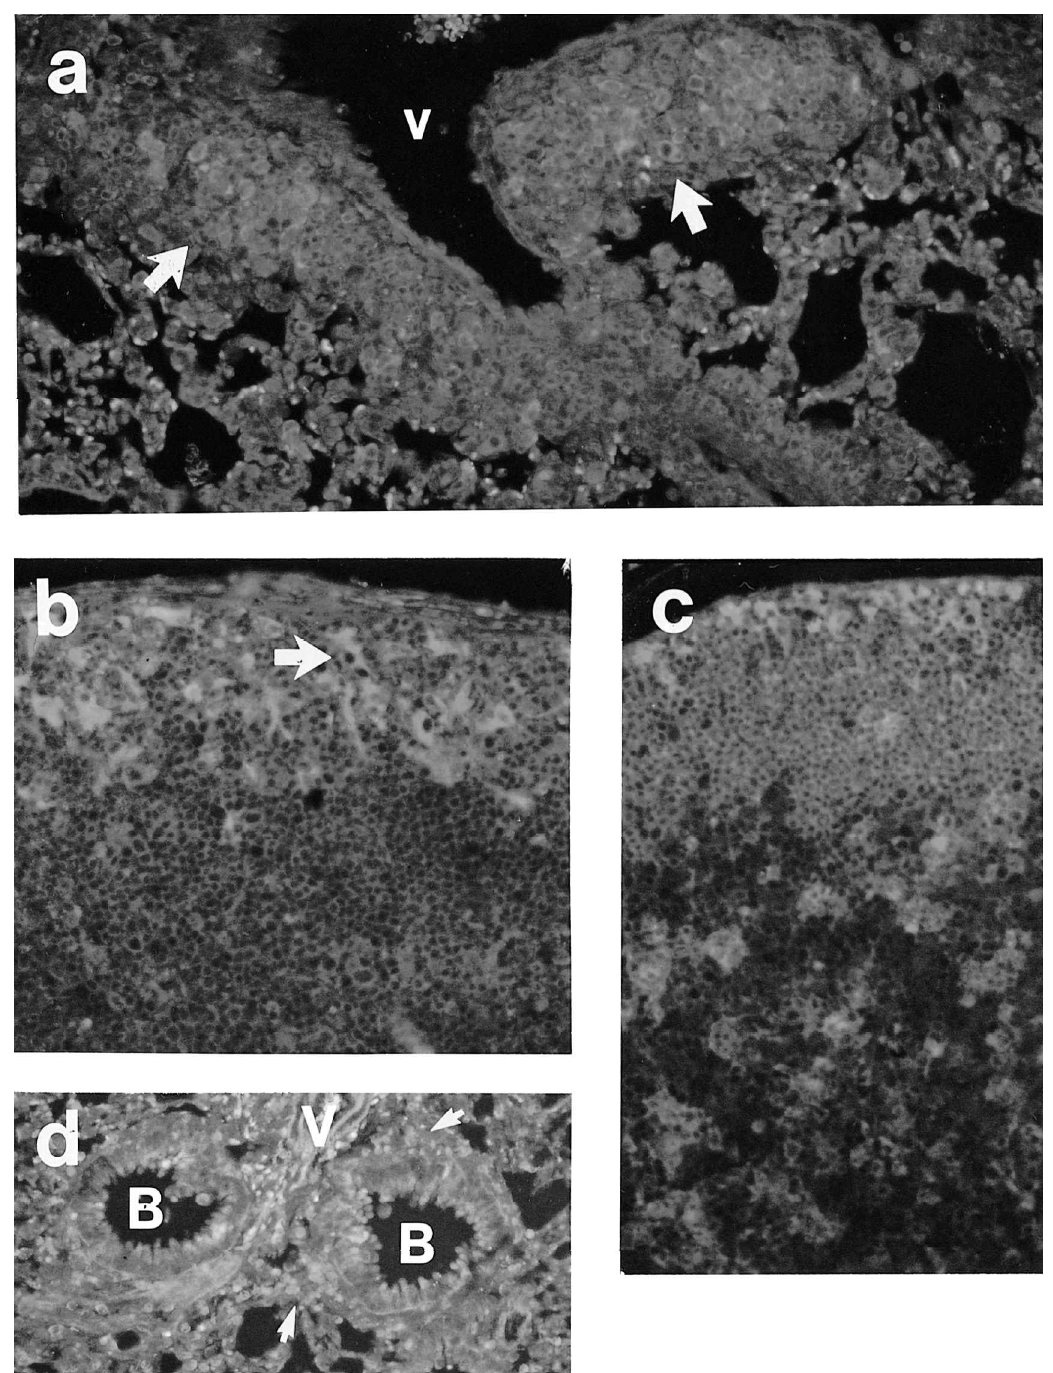
FIG. 3. Immunohistochemistry. Visualization of MIF-expressing cells in the pulmonary infiltrates (a) and tracheobronchial lymph nodes (b and c) of OVA challenged mice, and visualization of MPO-positive cells in the lungs of LPS-challenged mice (d). A majority of the leukocytes in the pulmonary infiltrates (arrows) of OVA-challenged mice were stained with anti-MIF serum (a). Interestingly, large, intensely MIF-positive cells with dendritic shape (arrow) were seen in the superficial cortex of the tracheobronchial lymph nodes in OVA-challenged mice (b). Lymphocytes, mainly located in the cortex, were also stained for MIF, although less intensely (c). In deeper portions of the lymph nodes many cells were unstained (c). A multifocal perivascular and peribronchial MPO-positive (neutrophilic) distribution (arrows) was seen at 4h after intratracheal LPS-challenge (d). In (a) and (d) a slight yellowish auto-fluorescence, mainly located in the lung parenchyma, is observed. B = bronchus, V = blood vessel. Original magnification 3